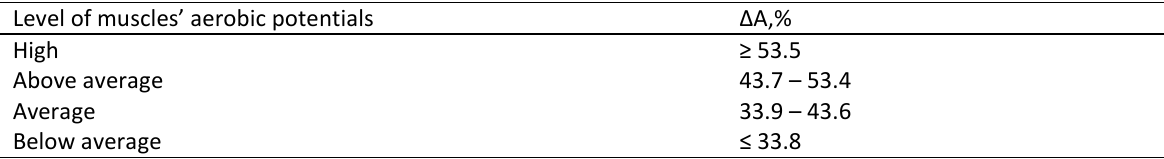
Table 4. Integral assessment of muscles’ anaerobic abilities, depending on EMG amplitudes’ increment (∆А,